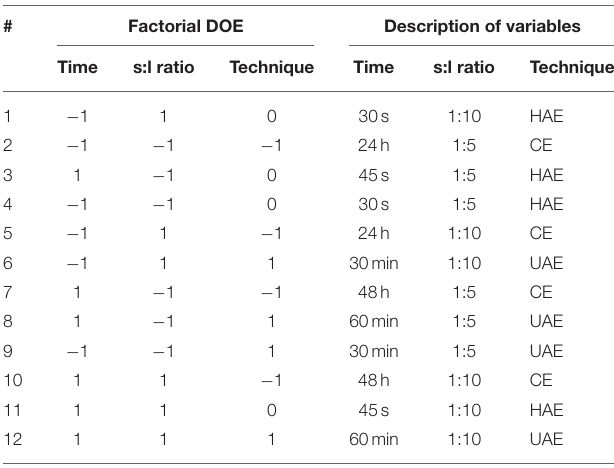
TABLE 1 | DOE factorial for the optimization of the extraction of total phenolics and especially oleuropein from olive mill leaves.